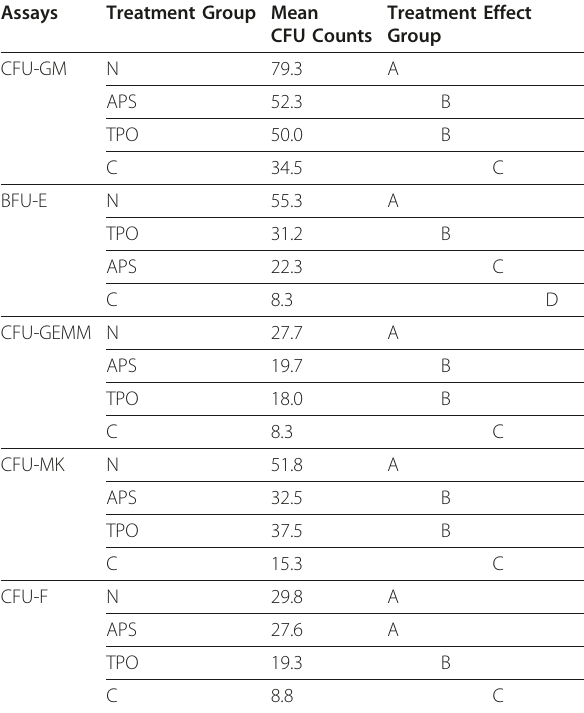
Table 1 Effect of APS on the formation of